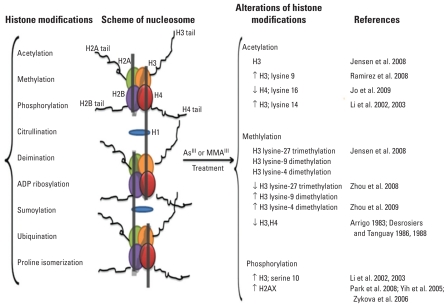
Histone modifications affected by AsIII and MMAIII exposure. Major posttranscriptional histone modifications of the nucleosome are listed on the left. Modifications of specific histone proteins reported in the literature as altered by arsenic exposure are shown on the right.